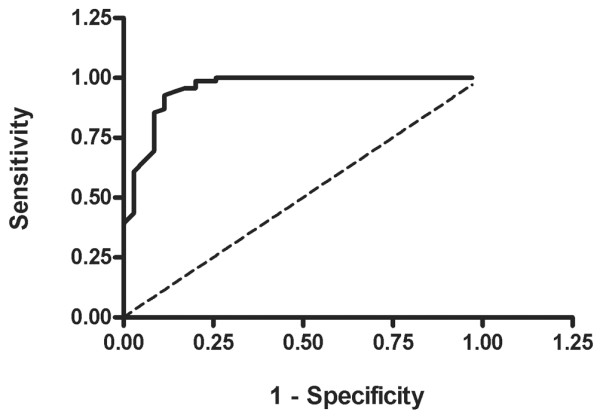
Receiver-operator curve using near infrared spectroscopy derived interval time for a threshold of cerebral perfusion pressure <25 mmHg. Area = 0.95 (95% confidence interval 0.92 to 0.99), p < 0.0001.